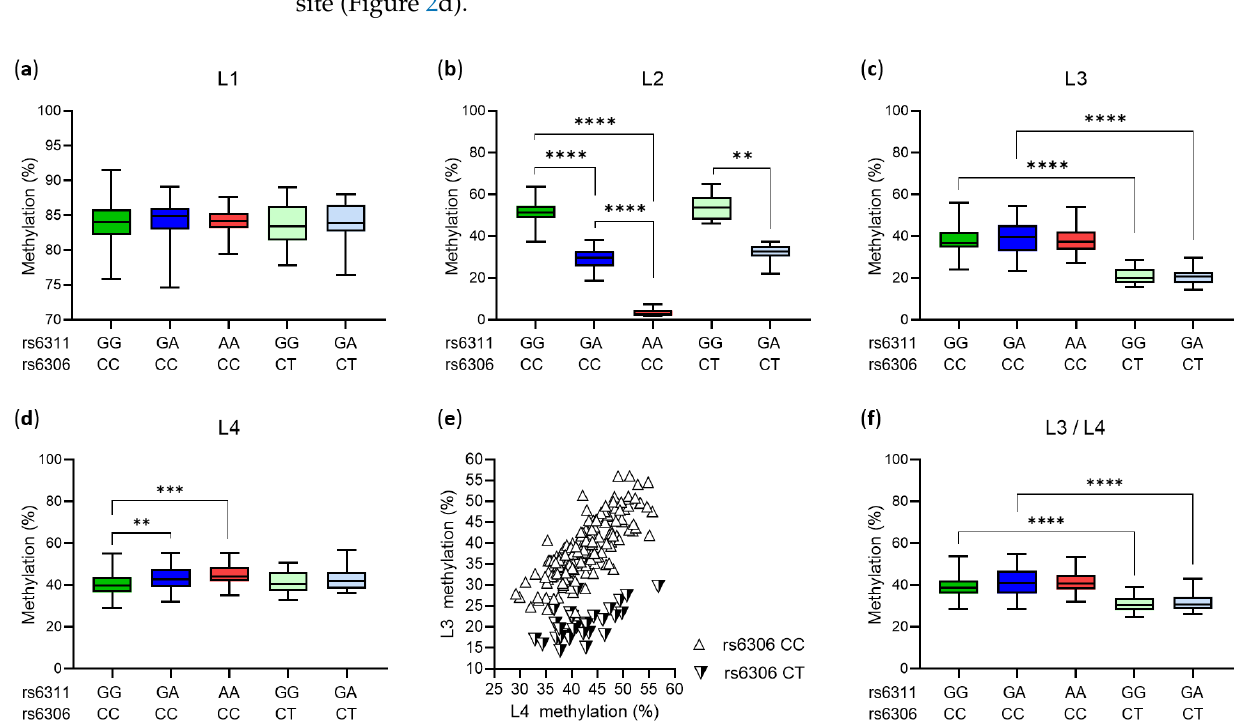
Figure 2. Placental HTR2A methylation in relation to neonatal genotype. ( a – f ) Subjects were divided into six subgroups based on the rs6311/rs6306 genotype combinations found in our study sample (GG/CC, n = 55; GA/CC, n = 73; AA/CC, n = 37; GG/CT, n = 20; GA/CT, n = 13; GG/TT, n = 1 (not shown)); methylation data are shown as boxplots with whiskers from minimum to maximum. Differences between subgroups were tested with Kruskal – Wallis test or one-way ANOVA: ( a ) p = 0.828; ( b , c , f ) p < 0.0001; ( d ) p = 0.0003. Where appropriate, multiple comparisons were made between rs6311/rs6306 genotype combinations differing by one of the two genotypes; significant differences are indicated (** p < 0.01, *** p < 0.001, **** p < 0.0001 by ( b , c , f ) Dunn’s or ( d ) Sidak’s post-hoc test). ( a ) Methylation at L1 ( −1 665) did not differ by rs6311 or rs6306 genotype. ( b ) Methylation at L2 ( −1 438)